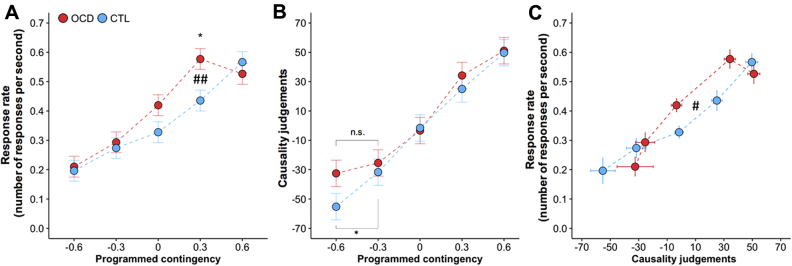
Mean response rate and causality judgments for control (CTL) group and obsessive-compulsive disorder (OCD) group. (A) Mean response rate by contingency (ΔP). Both groups responded more for higher contingencies. However, patients with OCD showed reduced sensitivity to instrumental contingency. (B) Subjective judgments of causality increased as a direct function of response-outcome contingency in both groups. Data are presented in ascending order of programmed contingency, but contingencies were experienced by each subject in a semirandomized order. Error bar indicates Fisher’s least significant difference to facilitate post hoc comparisons (error bars are ± 0.5 least significant difference). However, in the context of mixed designs, as in this case, this error bar can be used only for within-subject comparisons. The difference between OCD and CTL groups in mean causality judgments at ΔP = −0.6 was not significant. However, CTL subjects, but not patients with OCD, subjectively detected a difference between neighboring levels of negative programmed contingency between ΔP = −0.3 and ΔP = −0.6). (C) Response rate as a function of causality judgment by group. The two populations differentially employed action-outcome knowledge to guide their behavior. Points and error bars (SEMs) show values clustered by programmed contingency. As described in the main text, data were collapsed across blocks having equal contingencies (ΔP = −0.6, block 6; ΔP = −0.3, block 5, block 9; ΔP = 0.0, block 2, block 3, block 4, block 8, block 12; ΔP = 0.3, block 7, block 11; ΔP = 0.6, block 1, block 10. See Table 2 for naming of the blocks). Programmed contingency refers to the a priori experimentally programmed contingency resulting from the a priori programmed conditional probabilities. *p < .05, within-group comparison; ##p < .01, interaction; #p < .05, group × quadratic causality judgment interaction. n.s., not significant.